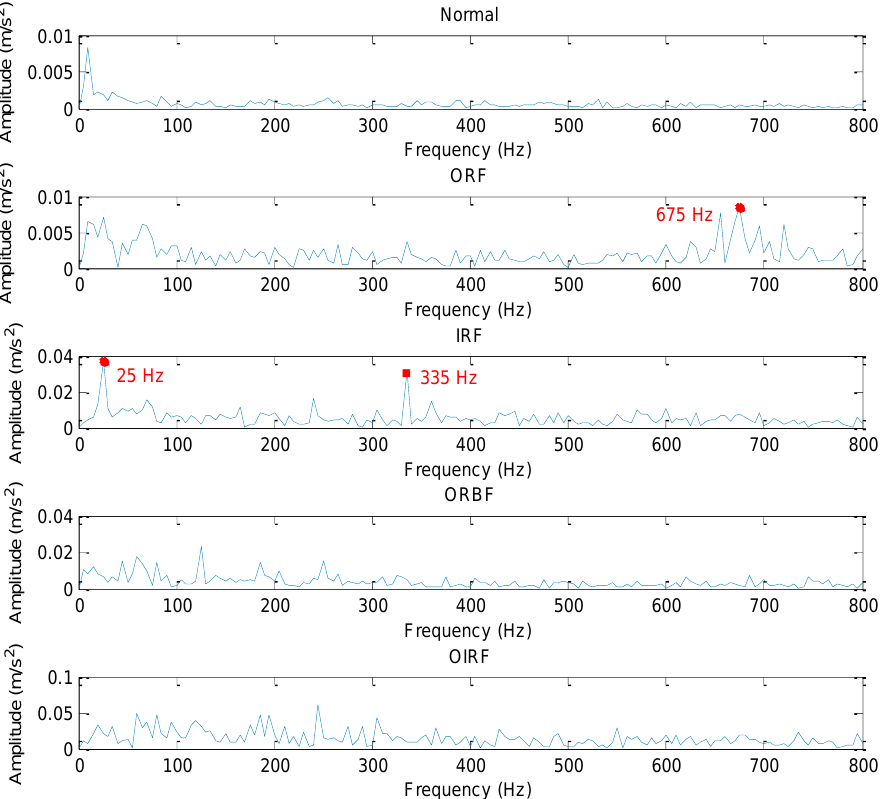
ff erent bearing vibration